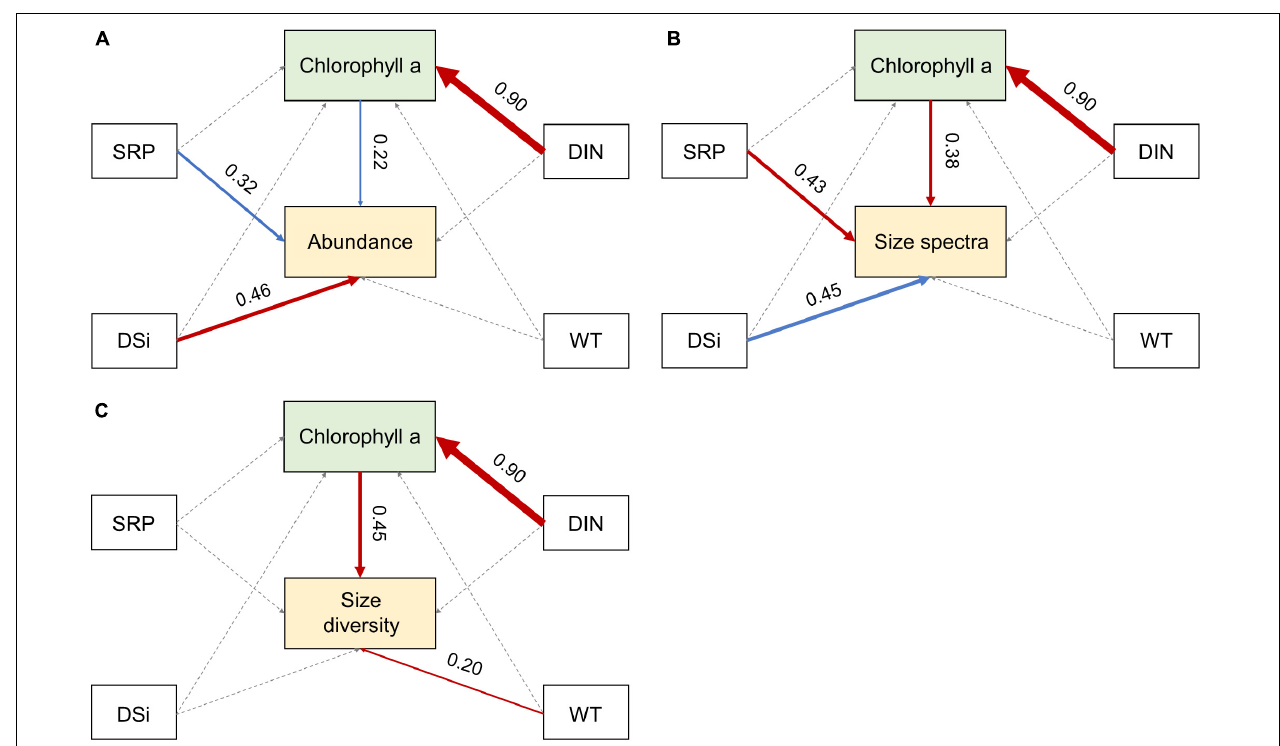
FIGURE 6 | Result of SEM for the direct and indirect effects of the selected environmental variables on zooplankton community (A) Abundance, (B) Size spectra, (C) Size diversity. The red solid arrows indicate the negative effects, blue solid arrows indicate the positive effects, and the dashed gray arrows represent non-significant effects. The width of arrows is weighted according to standardized path coefficients shown above the arrow. TABLE 2 | The mean equivalent spherical diameter (ESD) of each zooplankton group and the results of linear regression analyses between different zooplankton groups and phytoplankton biomass (chlorophyll a ) in the Xiangxi Bay of Three Gorges Reservoir. Mean ESD ( µ m) Regression coefficient intercept R 2 P